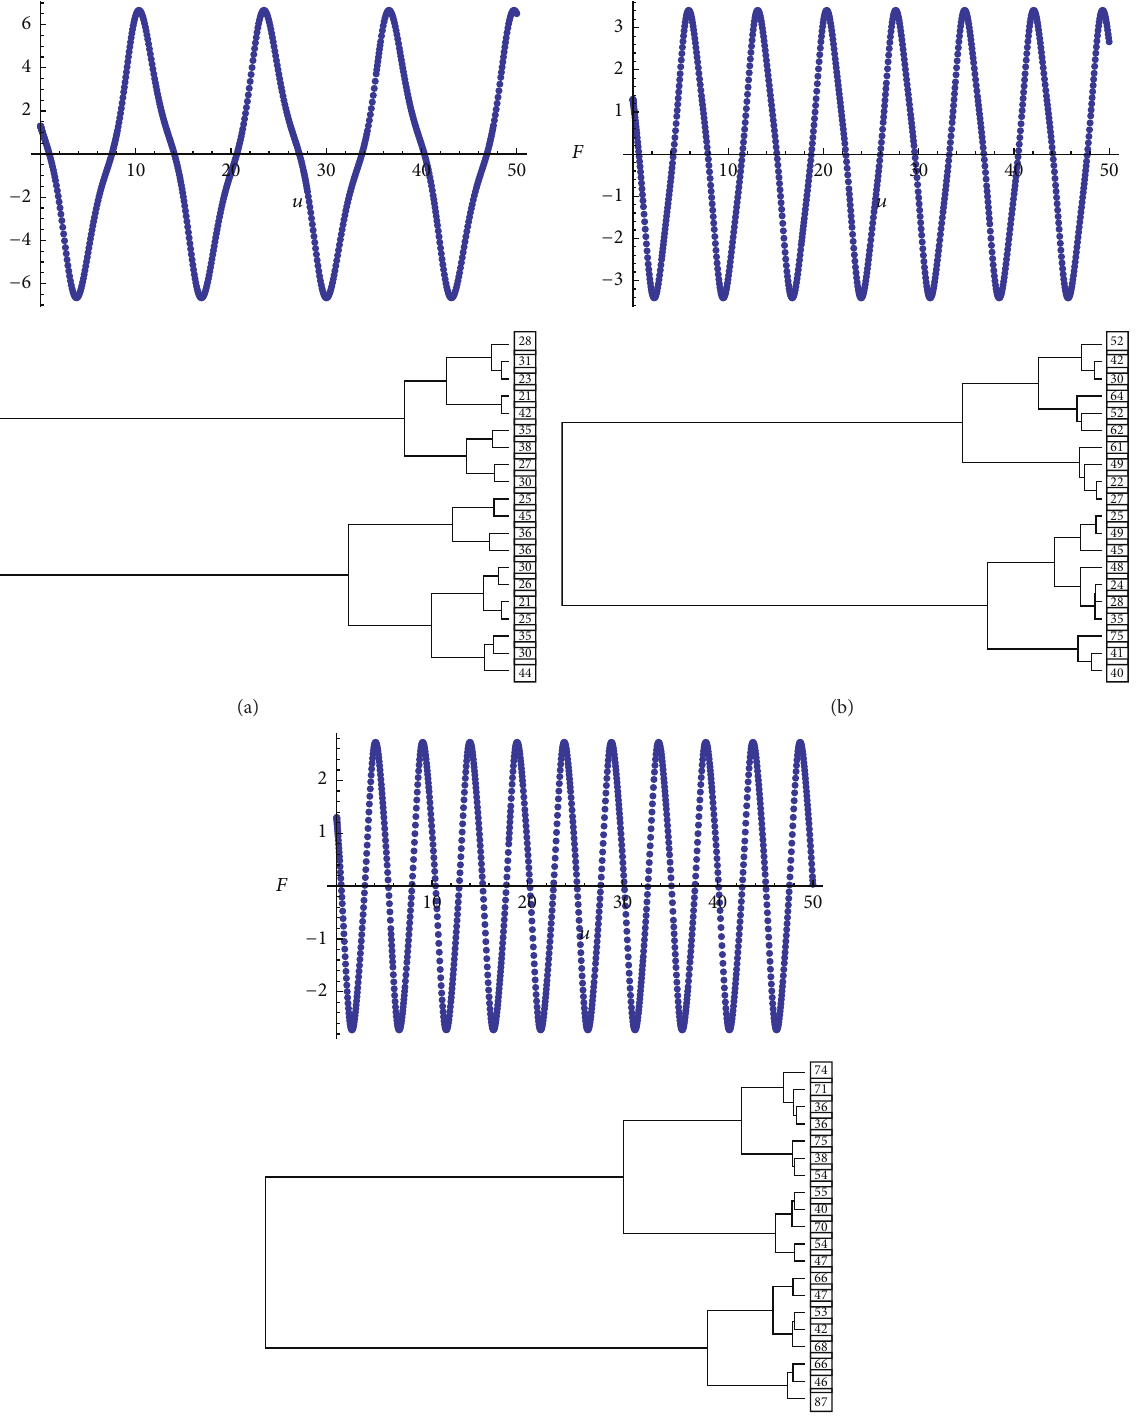
Figure 6: Time series and the resulting dendrogram from hierarchical clustering of GNDES for (a) 𝛾 = 0.5 , (b) 𝛾 = 1 , and (c) 𝛾 = 1.5